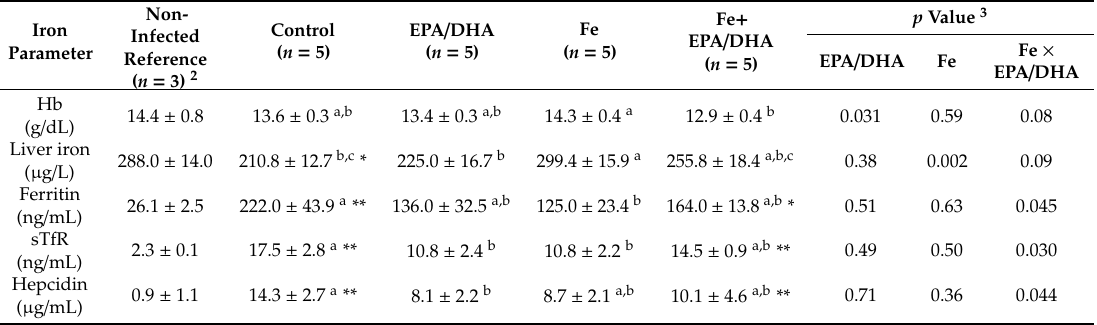
Table 3. Biomarkers of iron status and anemia of infection in Mtb -infected mice receiving control, EPA / DHA, Fe, or Fe + EPA / DHA diets for three weeks 1